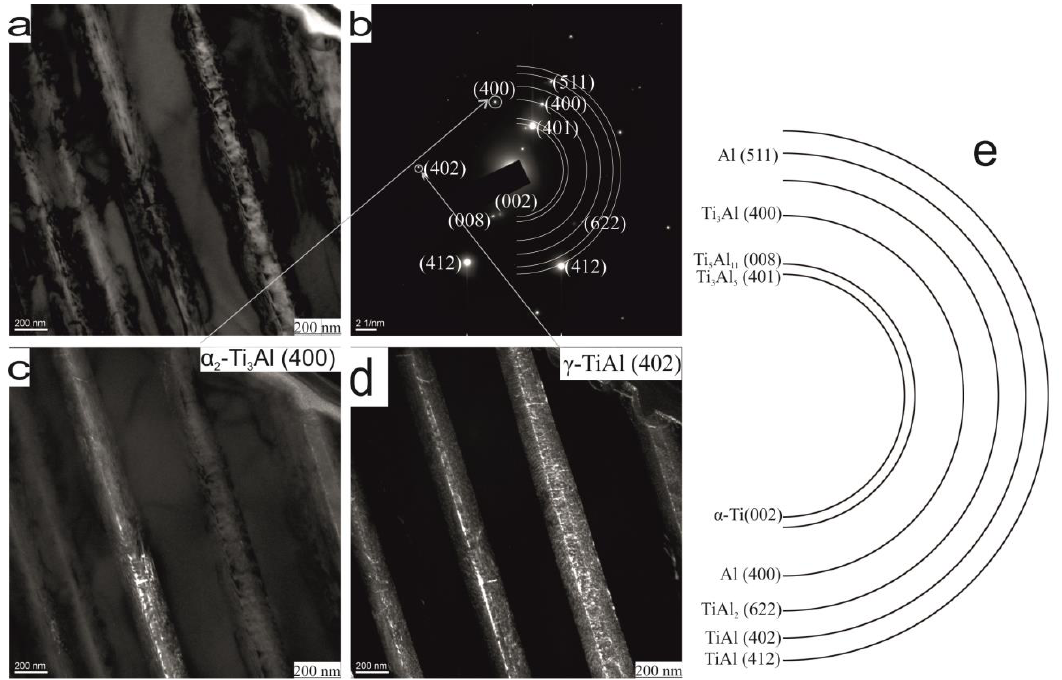
Figure 4. Electron microscope images of the matrix of the initial alloy TA: ( а ) bright-field image; ( b ) microdiffraction pattern; ( c ), ( d ) dark-field images in reflexes, marked by arrows; ( e ) microdiffraction pattern identification.